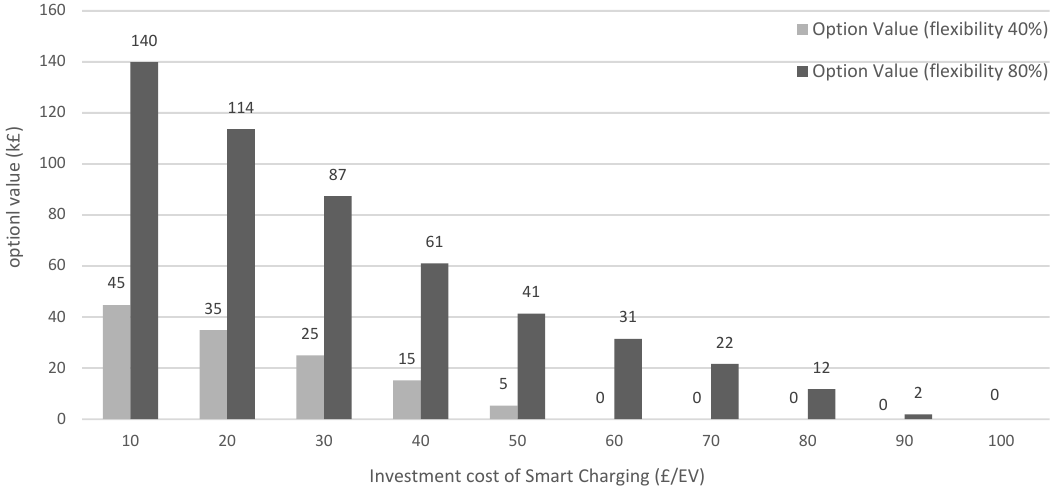
Figure 18. Option Value of investing in Smart Charging of EV (vertical axis) as a function of its investment cost (horizontal axis), for different values of Smart Charging flexibility, conducted via BIF. The comparison of the proposed BIF with the SOF demonstrates that, in almost all cases, both approaches lead to the same optimal solution. Therefore, the proposed BIF is validated using the well-established